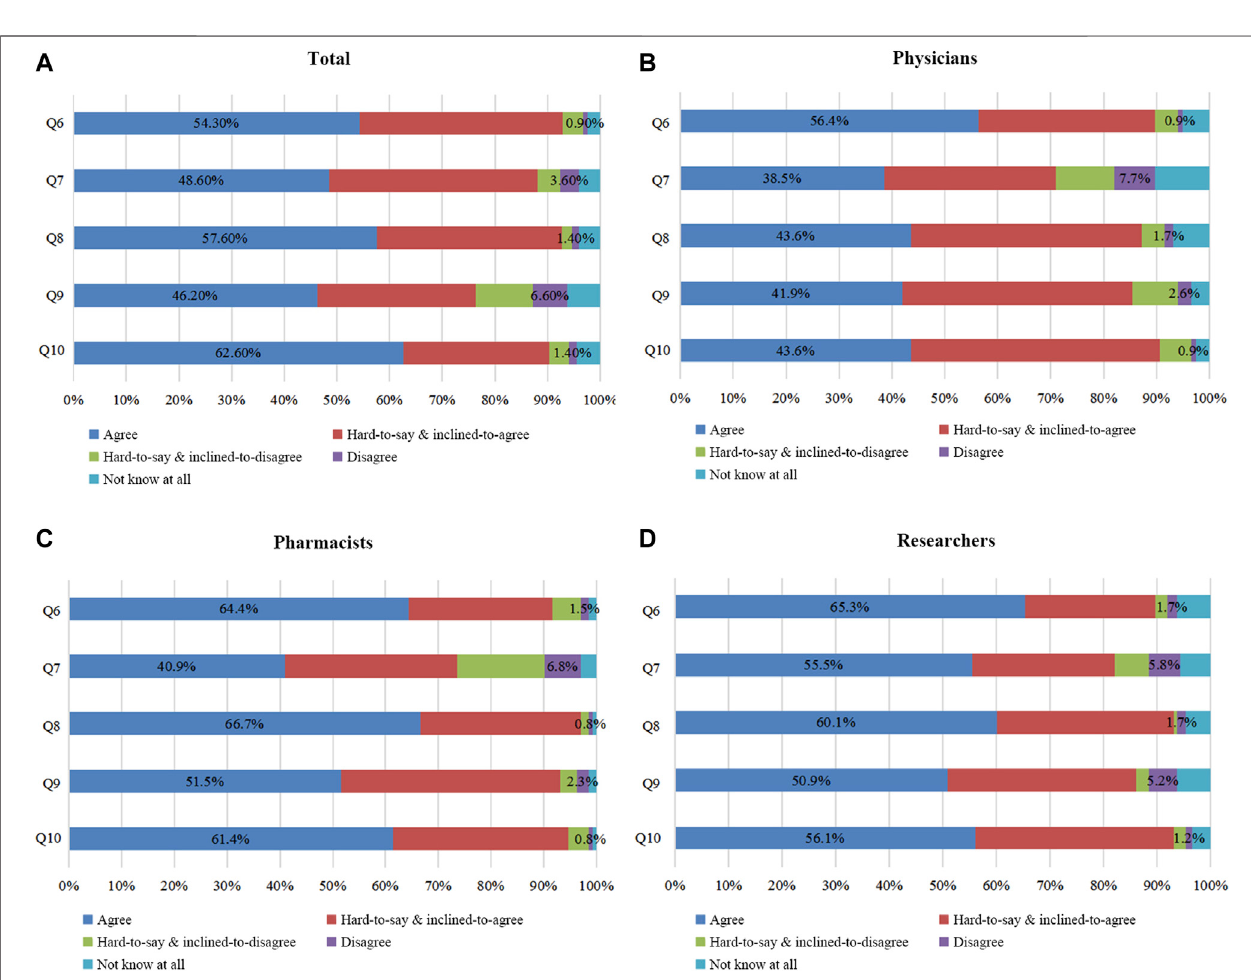
FIGURE2| AwarenesssurveyofPGxamongallrespondents. Figure2A :Allparticipants ’ awareness surveysonquestions(Q)6 – 10. Figures2B – D :Q6 – 10were assessed by physicians, pharmacists, and researchers. Q6 In your opinion, is PGx capable of aiding in patient selections of optimal drugs? Q7 In your opinion, can PGx assist patients in using correct doses? Q8 In your opinion, can PGx assist patients in preventing severe adverse reactions? Q9 In your opinion, can PGx DNA detection lower the economic burdens and save medical costs for patients? Q10 In your opinion, should clinical application of PGx DNA detection be further promoted?